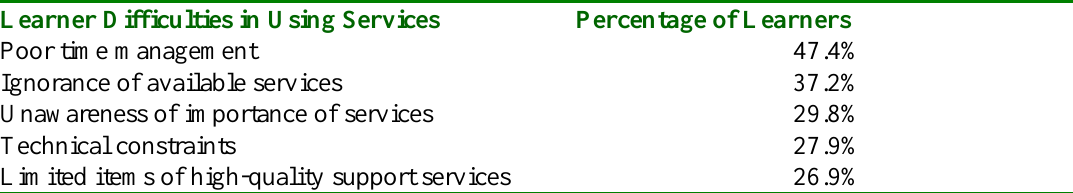
Table 8. Five major learner difficulties identified in utilizing learner support